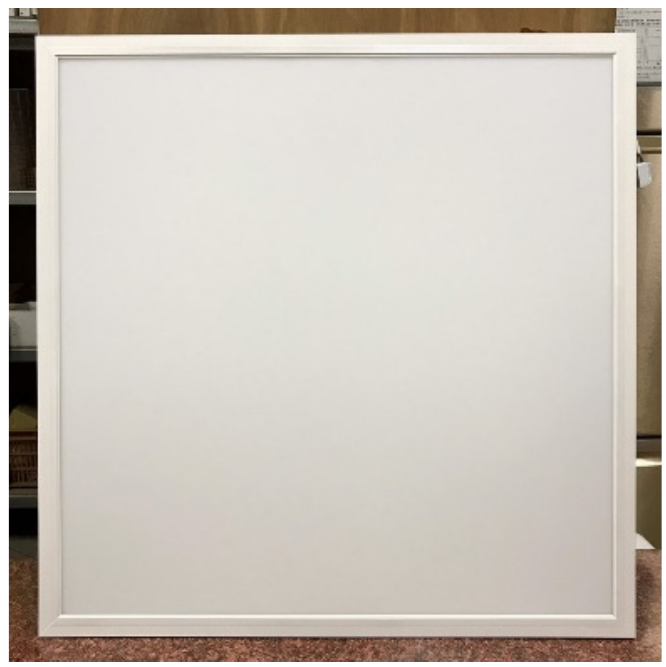
Figure 14. LED flat panel luminaire (LE) without fixing screw holes on the back.